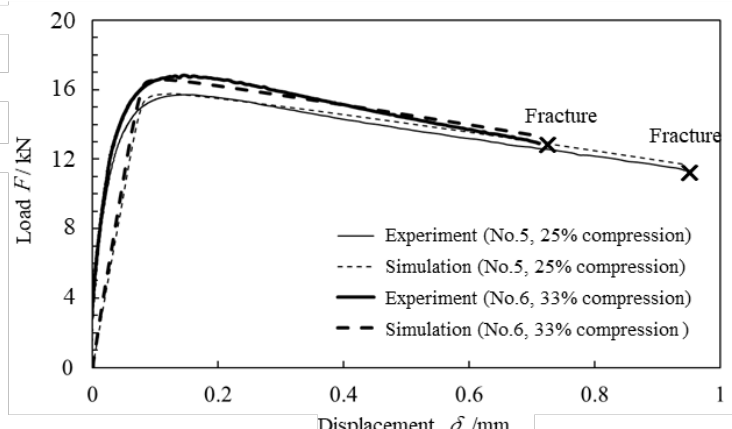
Figure 9. Load – displacement relationship in the uniaxial tensile test of notched round bar specimen with prior compression (Specimen A).